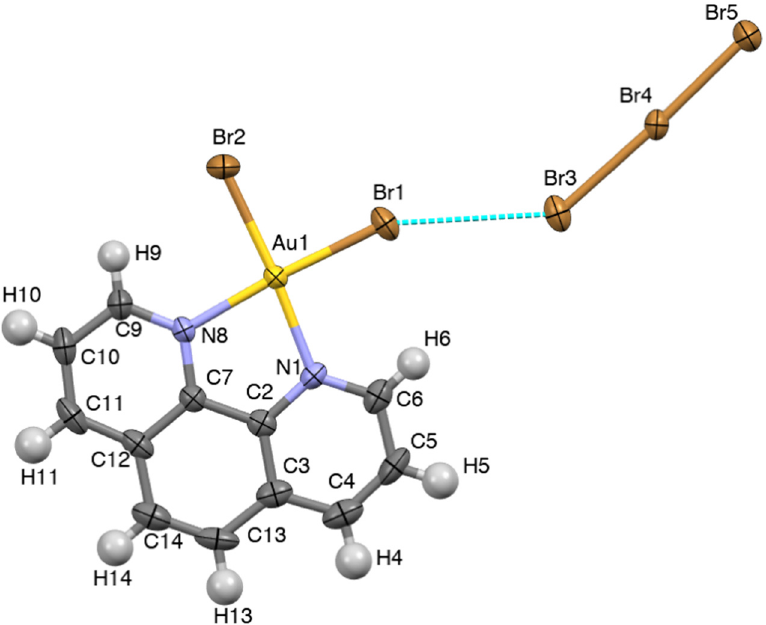
Figure 1. Molecular view of compound 1 laying on the ac plane. Ellipsoids were drawn at 60% probability level.